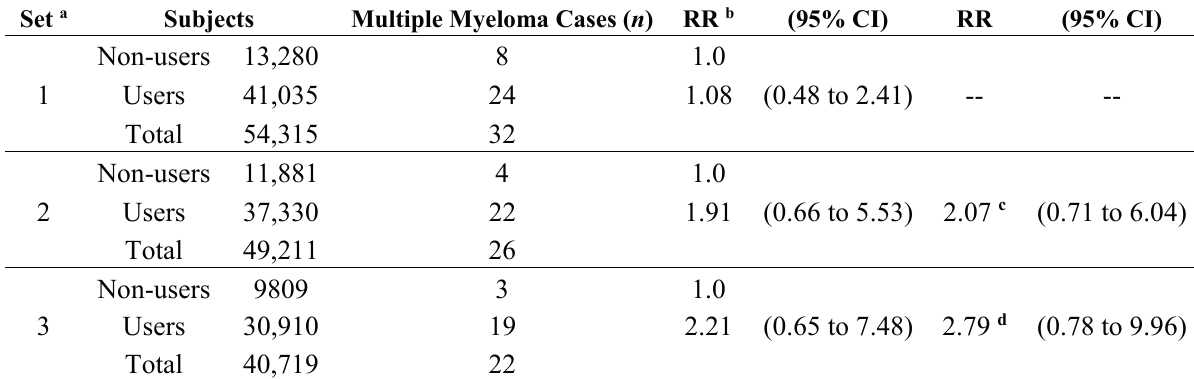
Table 1. Risks of multiple myeloma from the AHS in relation to use of glyphosate in three sets of